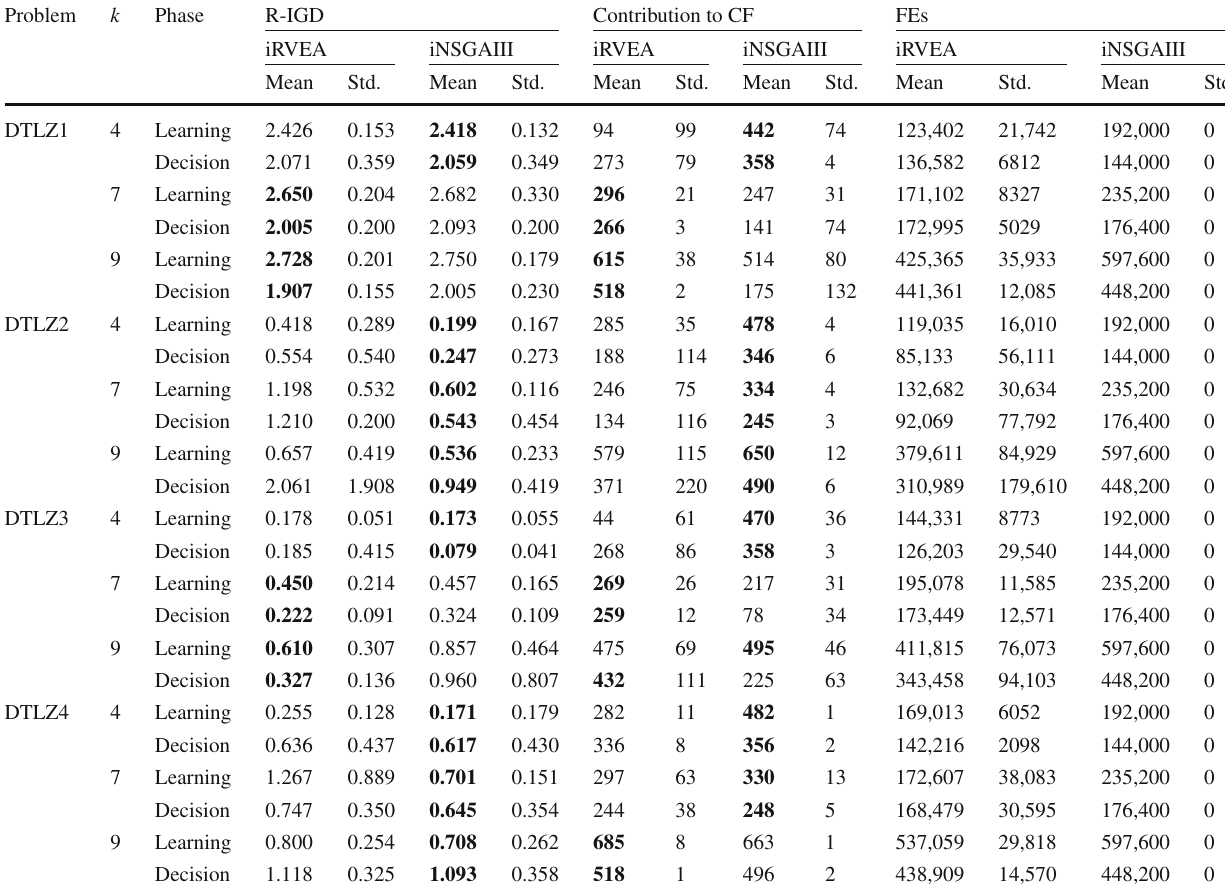
Table 1 Cumulative results of the comparison of iRVEA and iNSGAIII